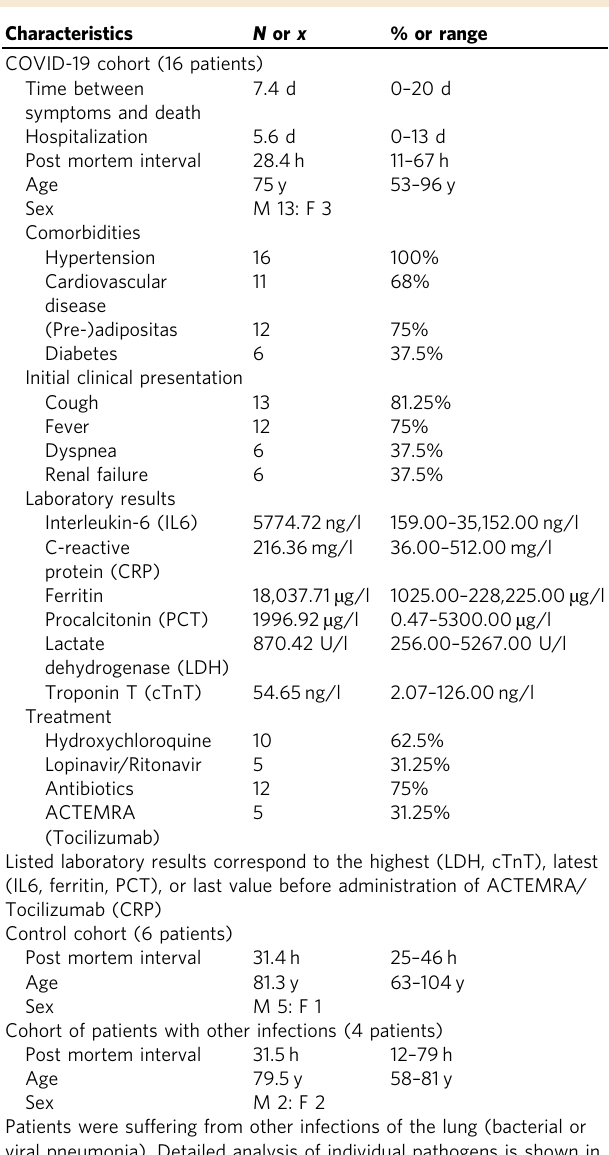
Table 1 Clinical data of all patients.